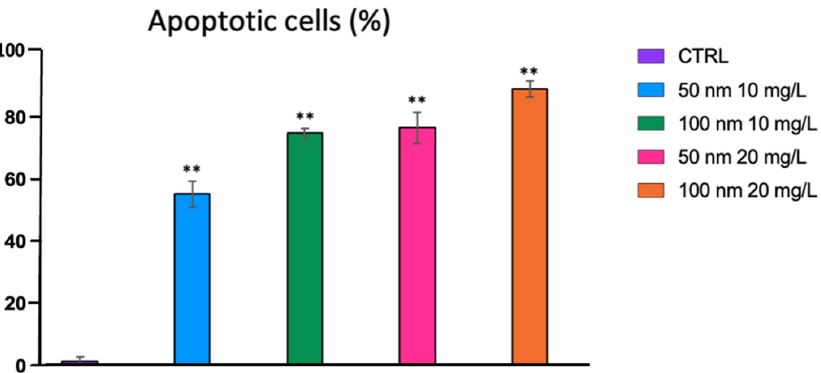
Figure 6. Percentage of organisms exposed to nPS-NH 2 positive for AO compared to the control group. The symbol ** indicates strong statistical significance ( p < 0.01).